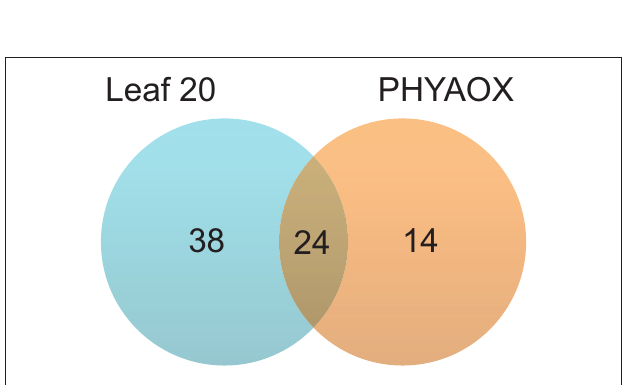
FiGure A4 | The Venn diagram of the result of ANOVA using metabolite profile data of PHYAOX and WT samples. The number in the left-hand circle indicates how many metabolites showed significant changes according to genotype-dependent differences. The number in the right-hand circle represents the number of significant metabolites with respect to photoperiod- dependent differences. The number in the middle represents the common metabolites between PHYAOX and WT samples. FDR